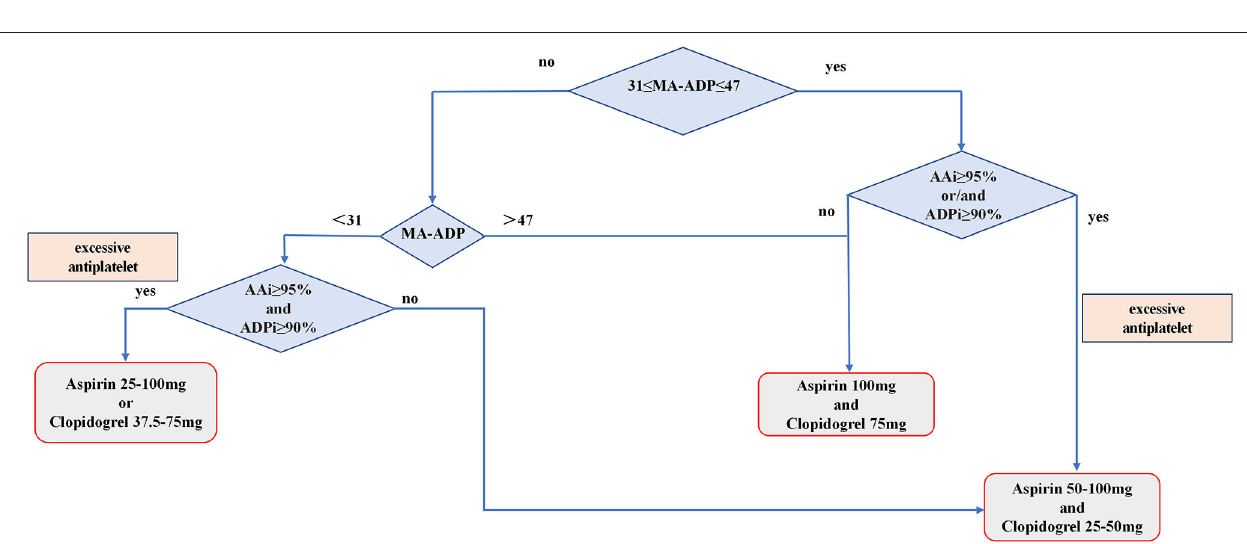
LVIS (MicroVention Terumo, Tustin, California, USA), and LEO stents (Balt, Montmorency, France) stents were used